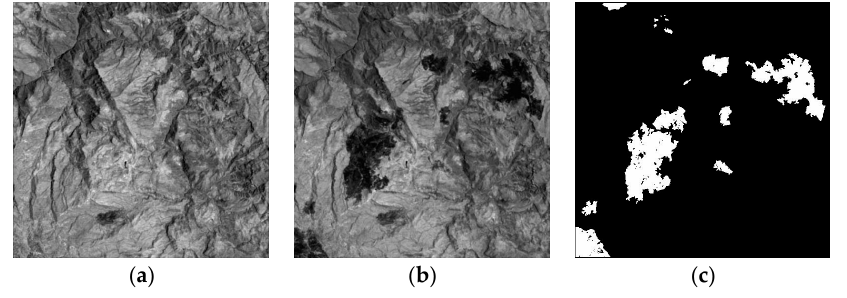
Figure 8. Mexico data set: ( a ) Image acquired in April 2000; ( b ) Image acquired in May 2005; ( c ) The reference change image.